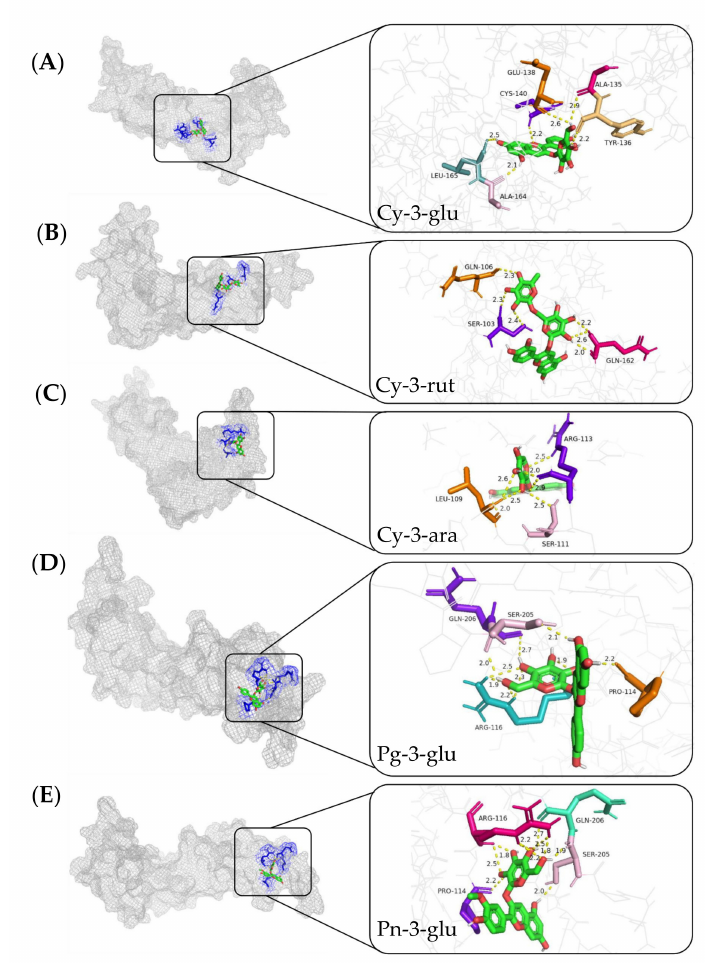
Figure 4. Use of Autodock software to analyze 100 docking models of five anthocyanin monomer compounds and proteins. Panoramic view showing the binding mode between Cy-3-glu ( A ), Cy-3-rut ( B ), Cy-3-ara ( C ), Pg-3-glu ( D ), Pn-3-glu ( E ), and REDD1.